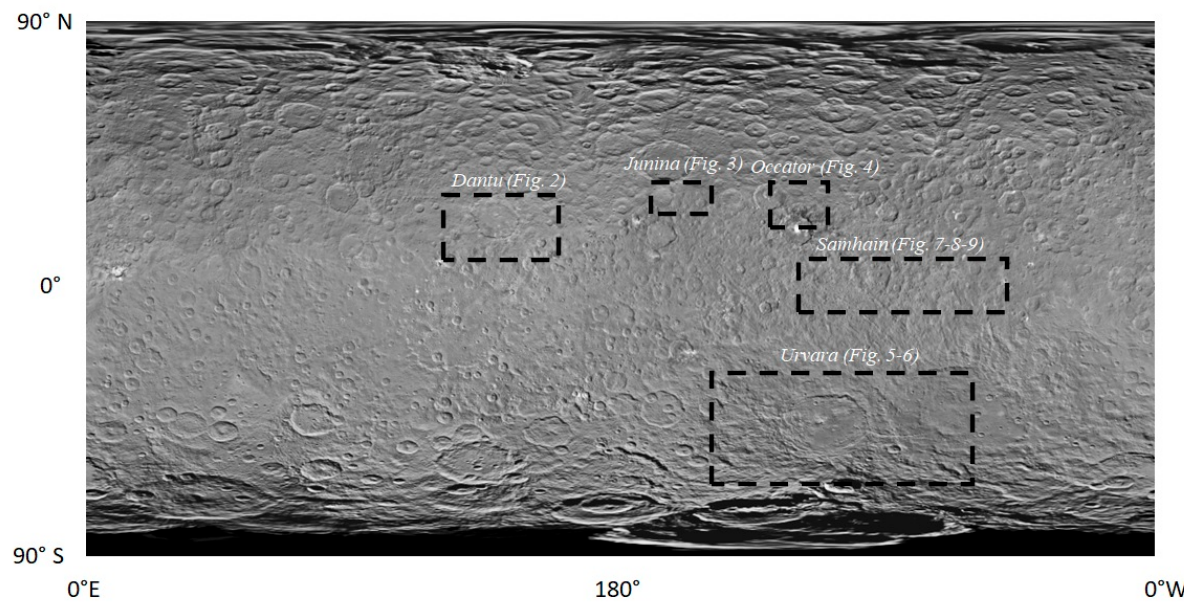
Figure 1. Location of linear features studied in this work over-imposed on the Ceres FC cylindrical map (USGS Astrogeology Science Center). Note that each square includes the areas imaged in the following figures, but each feature extends to wider areas. For the full features extension refer to [19].